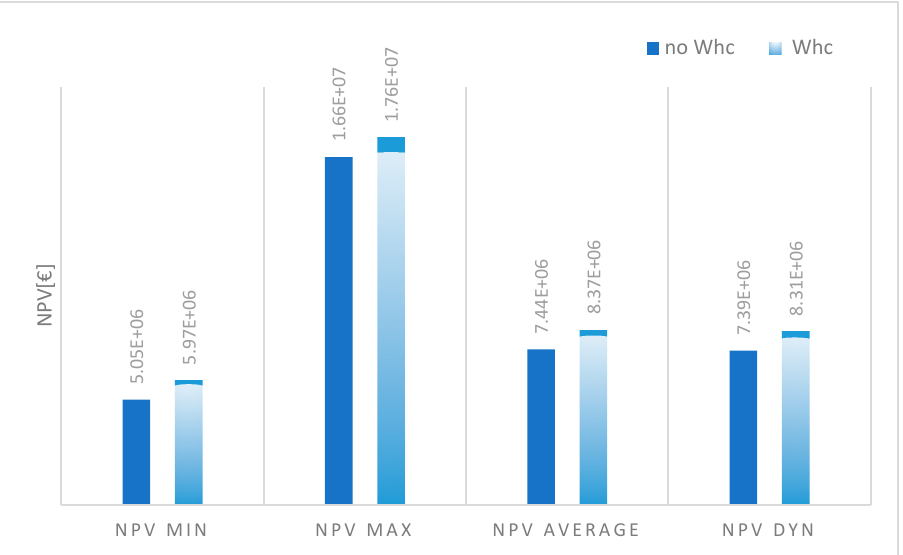
Figure 9. NPV calculation for 25 years, which was assumed as the lifespan of the project, where “no WhC” = no participation in the White Certificates mechanism, and “WhC” = participation in the White Certi fi cates mechanism.